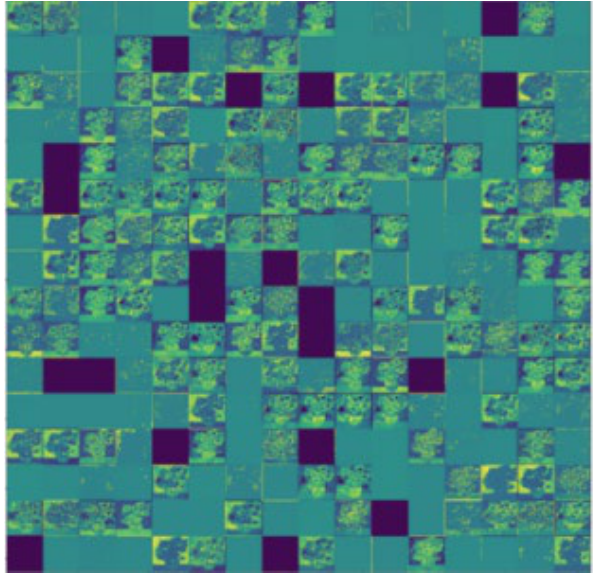
Figure 10. Visualization of the feature map of the convolutional layer conv3_1.